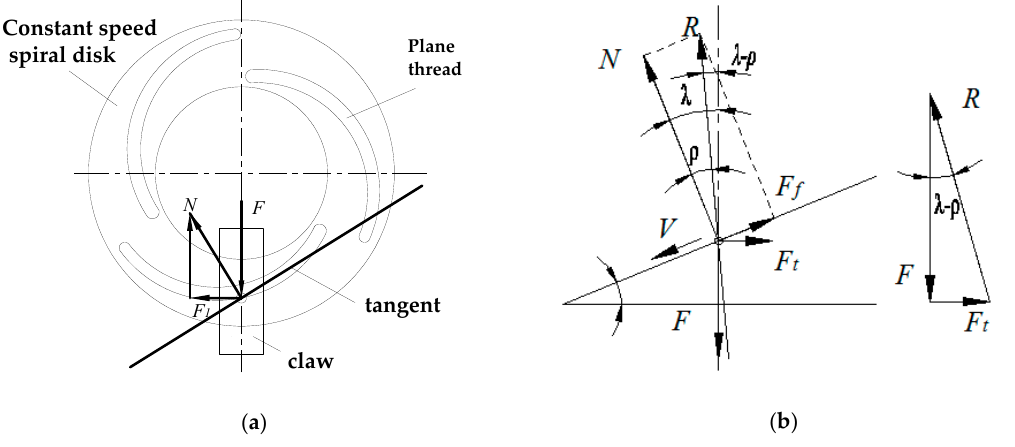
Figure 4. Force analysis of plane threads and claws: ( a ) Force analysis of plane threads; ( b ) Force analysis of plane claws.